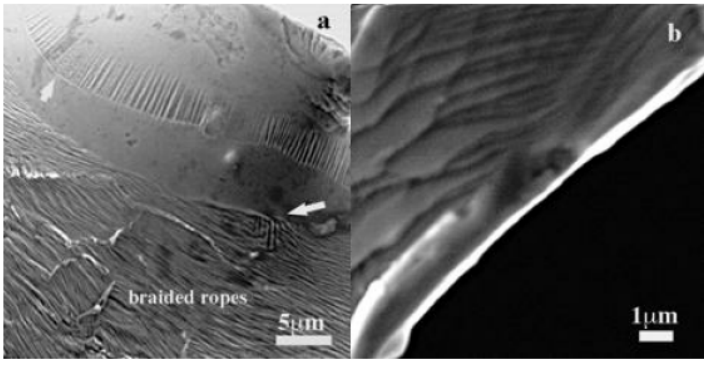
Mo B Zr (Zr3) BMG strip: shear bands and 66 6 18 10